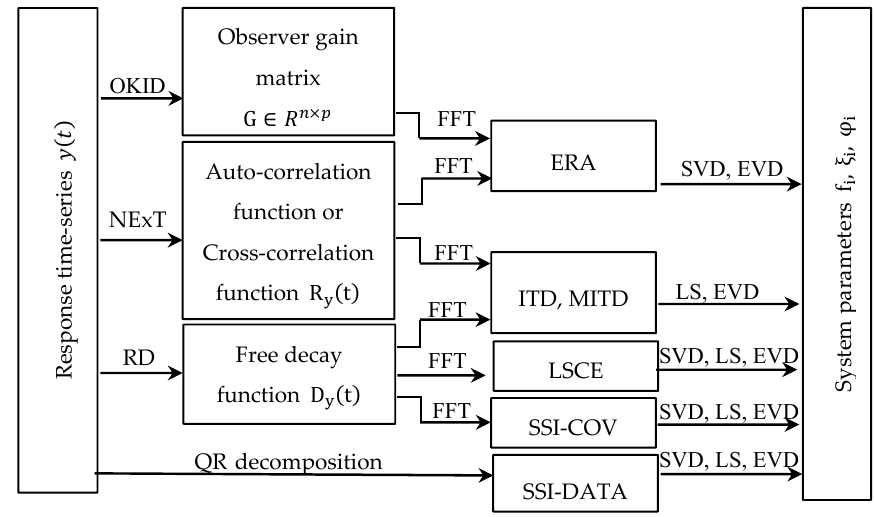
Figure 2. Schematic model for some of output-only time-domain modal identification methods.